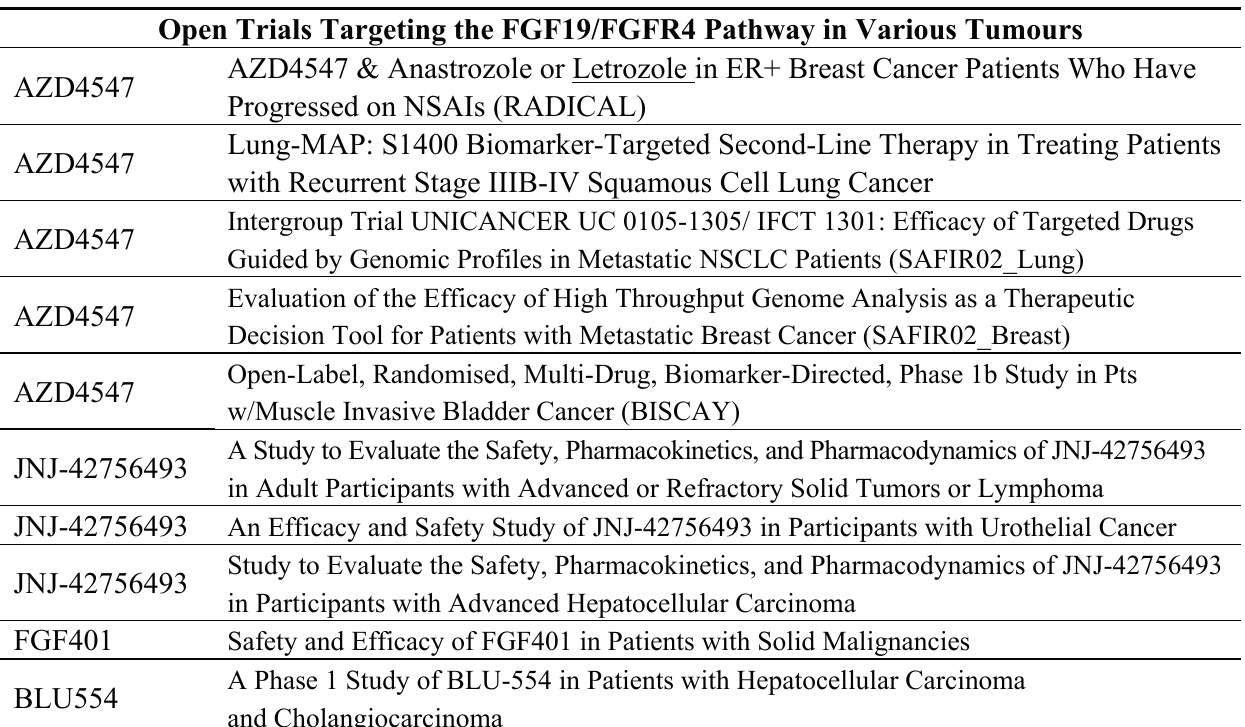
Table 1. Open trials with FGF19 and FGFR4 inhibitors in various